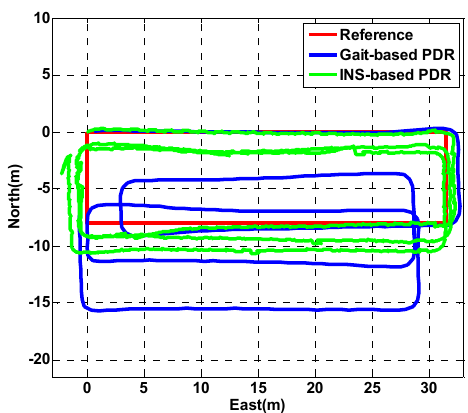
Figure 7. Trajectories of reference, gait-based PDR and INS-based PDR.